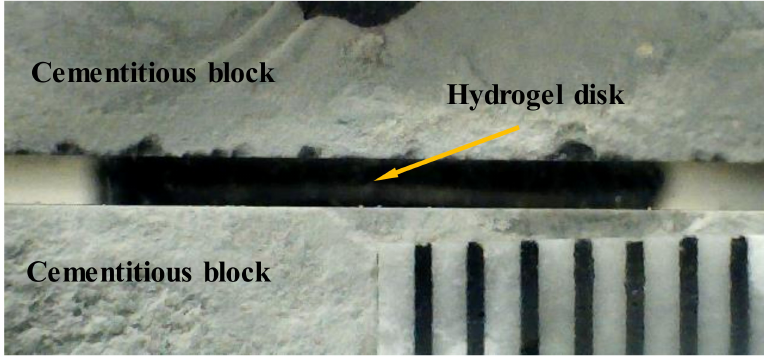
Figure 7. Image of the setup used in the desorption experiments with contact with cement paste